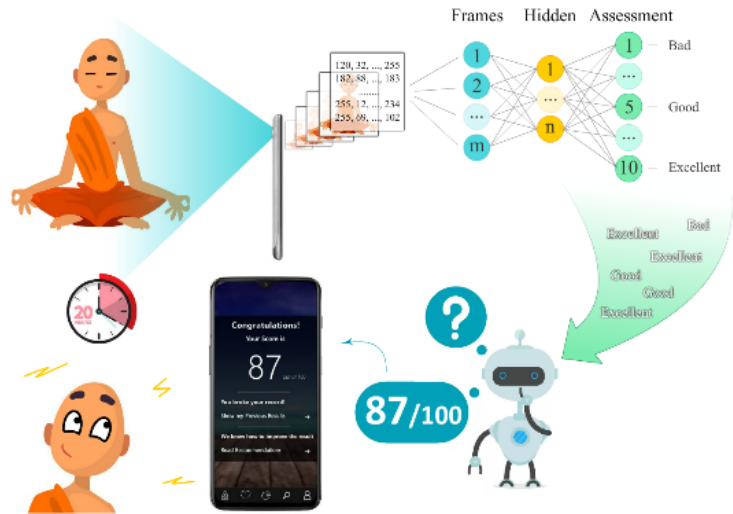
Figure 12. Neural network-based meditator seating pose detection.